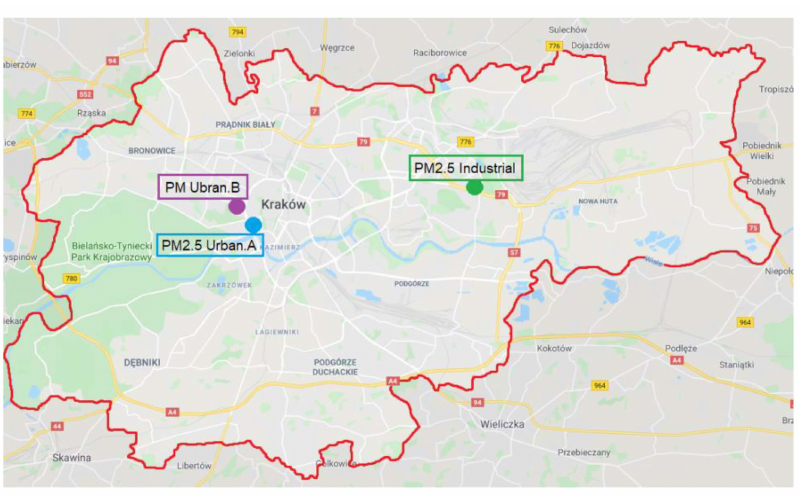
Figure 1. Localization of PM collectors in Krak ó